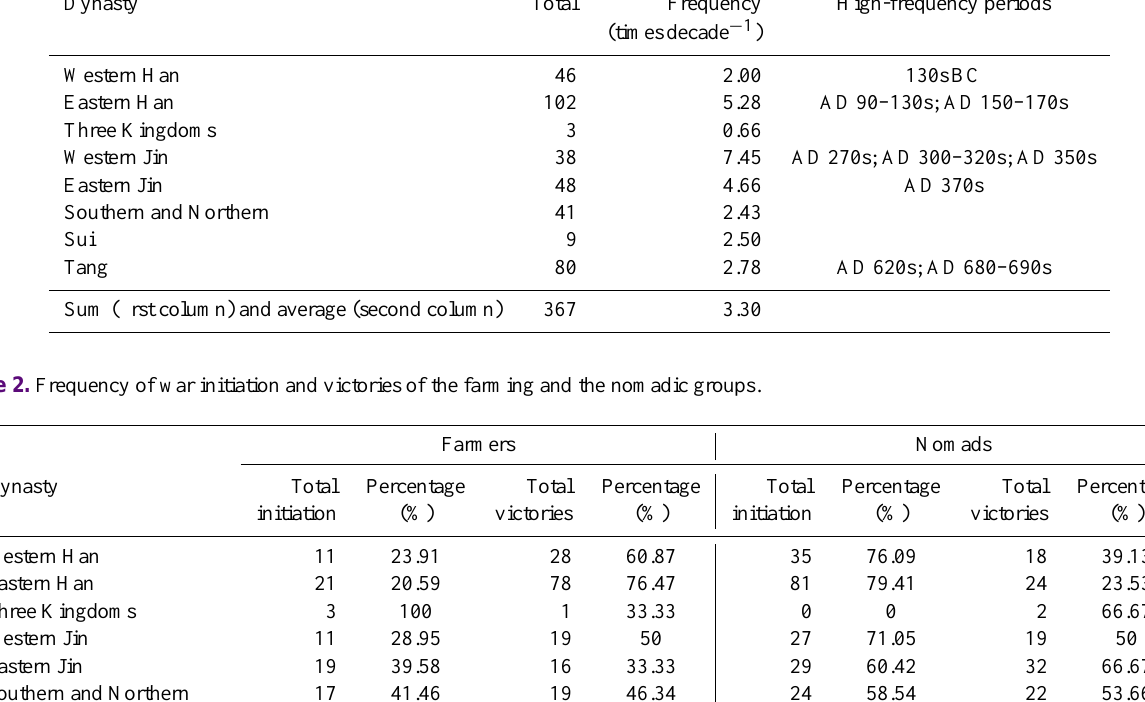
Table 1. Frequency of wars between the farming and nomadic groups from the Western Han Dynasty to the Tang Dynasty in China. Dynasty Total